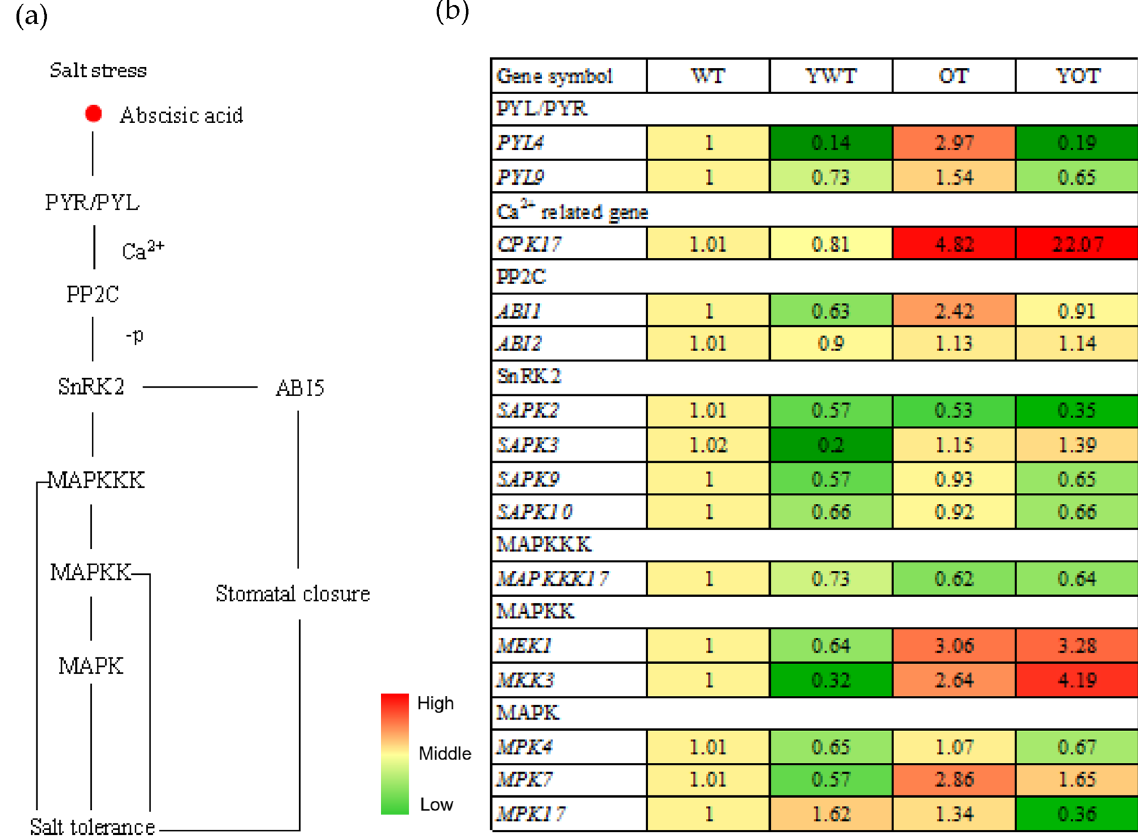
Figure 10. Expression analysis of genes involved in ABA and MAPK pathways: ( a ) the roadmap of ABA and MAPK pathways; ( b ) heat map of ABA and MAPK pathways-related gene expression; WT, wild-type tobacco; YWT, salt-stressed wild-type tobacco; OT, transgenic tobacco; YOT, salt-stressed transgenic